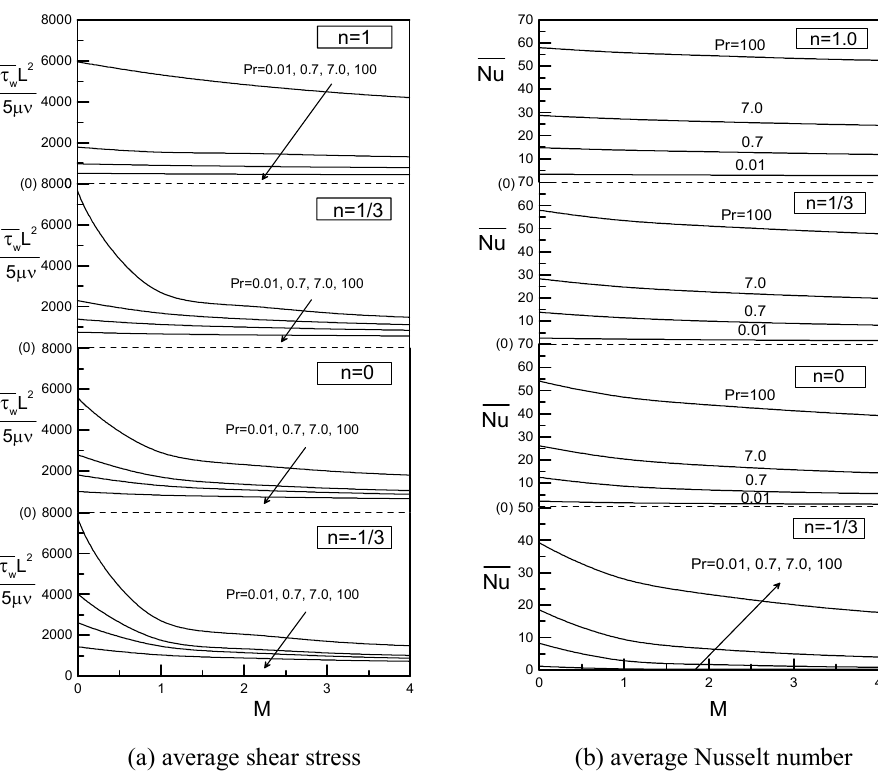
Figure 7 The variations of (a)average shear stress and (b)Nusselt number versus M for different Pr with φ =60°, n=-1/3, 0, 1/3,